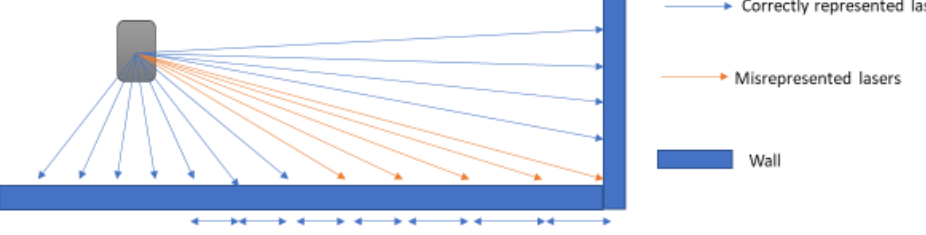
Figure 5. Laser beam hitting a straight wall. The difference between each neighbouring blue pules range measurement is smaller, and the difference in the orange pulses is larger.